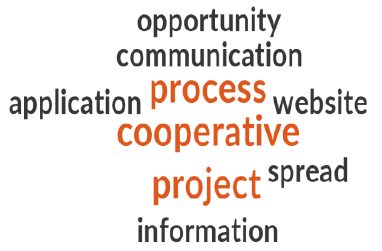
Figure 4. Word cloud of phrases that make up the Transparency category. Source: Own research. The more often a word appears, the larger the font.